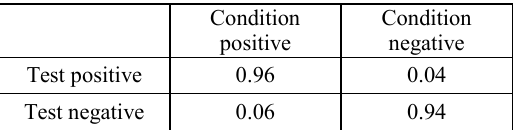
Table 2. Positive predictive value of the 19 Hz LDA test.